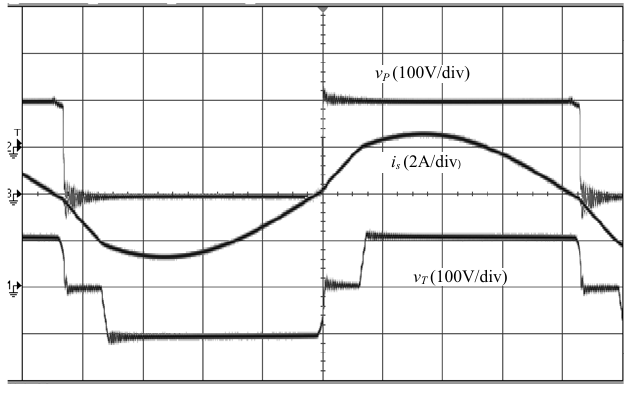
Figure 14. Experimental plot at: d > 1; V in = 100 V; V o = 100 V; P o = 150 W, nearly JCCM